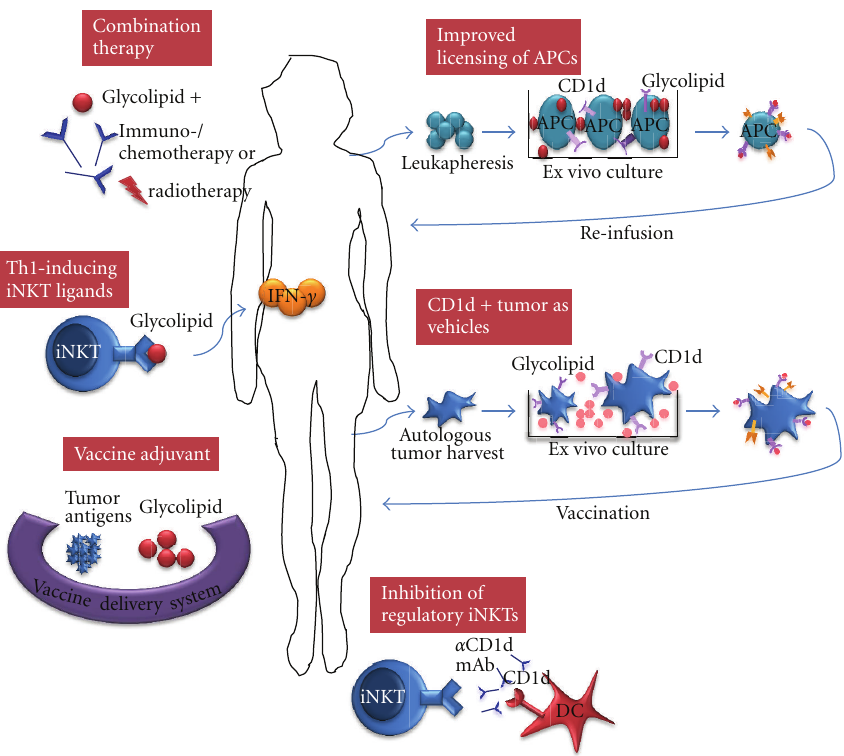
Figure 2: Multiple opportunities exist for innovations in iNKT-based cancer immunotherapy. Development of synthetic glycolipids that promote Th1 cytokine production by iNKT cells and the use of these agonists, including α -GalCer, as powerful adjuvants in cancer vaccines. Combinatorial approaches of iNKT stimulation with standard chemo-/radiotherapy or novel therapies that target other immune cells may result in synergistic e ff ects. Blocking the activation of regulatory iNKT cells will be beneficial in tumors where regulatory iNKT cells play a key suppressor role. Optimization of protocols for ex vivo loading and maturation of autologous DCs will ensure consistent and reliable stimulation of iNKT cells in vivo. CD1d-expressing tumor cells can also be used as source of iNKT-stimulating